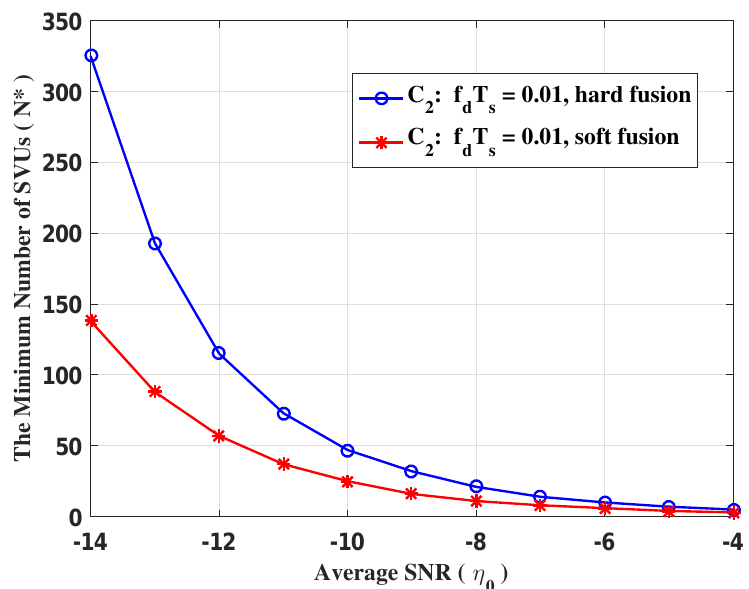
Figure 9. The minimum number of SVUs required to come up to an expected detecting performance for cooperative sensing ( K = 50, ξ 1 = 0.05, ξ 2 = 0.95).